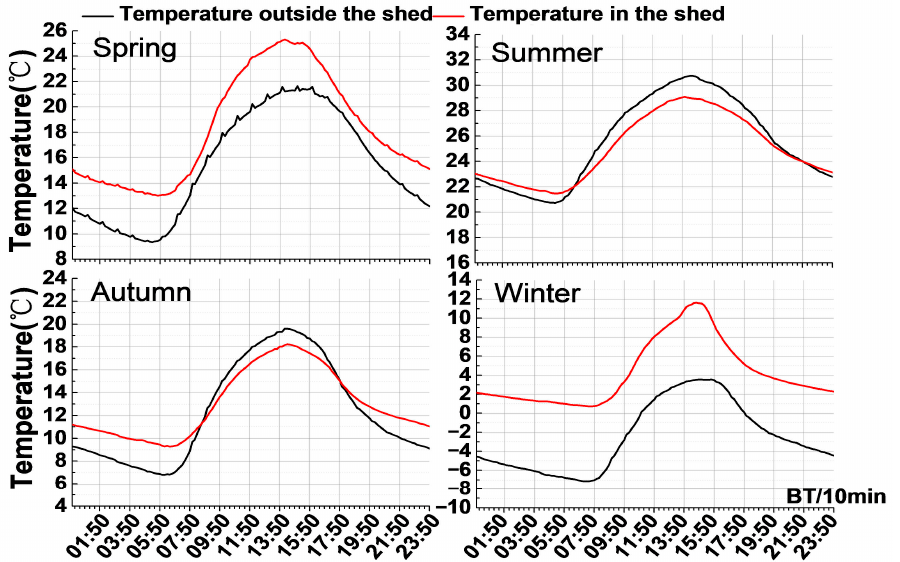
Figure 4. Diurnal variation of temperature inside and outside the greenhouse for Bailing mushrooms